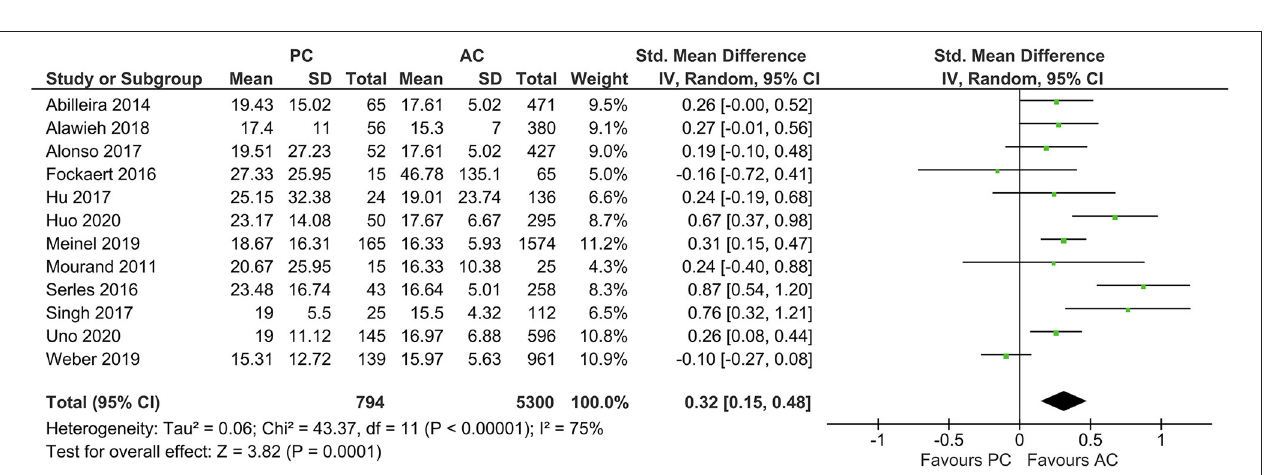
FIGURE 3 | Forest plot comparing the baseline characteristic “female sex” of patients with large vessel occlusion in the posterior circulation (PC) vs. anterior circulation (AC) who were treated with endovascular mechanical thrombectomy. Chi 2 , chi-square statistic; CI, confidence interval; df, degrees of freedom; I 2 , I -square heterogeneity statistic; M-H, Mantel–Haenszel statistic; P , p -value; Tau 2 , estimated variance of underlying effects across studies; Z , Z statistic.